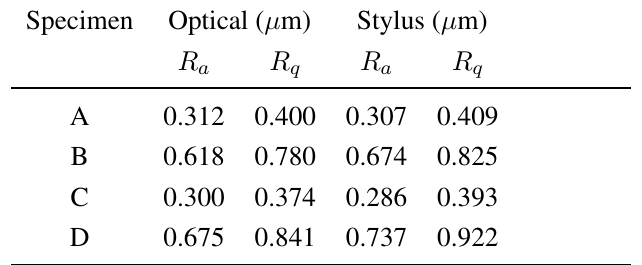
Table 1. Comparison between R device and the data obtained from an stylus (courtesy of